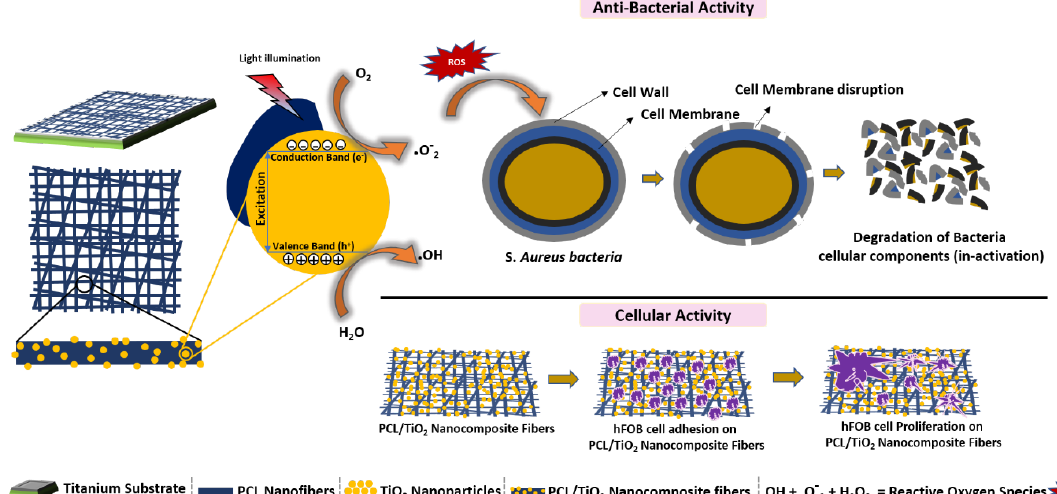
Figure 8. Schematic illustration for the mechanism of degradation bacteria by TiO 2 nanoparticles under UV radiation and cellular activity of PCL/TiO 2 nanocomposites.